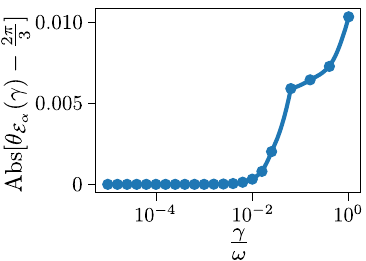
Fig. 3 Phase of the discrete time crystal (DTC) eigenvalues relative to 2 π ð γ Þ (cid:2) 2 π (cid:3) , the absolute (Abs) value of the deviation of the Abs ½ θ E 3 α